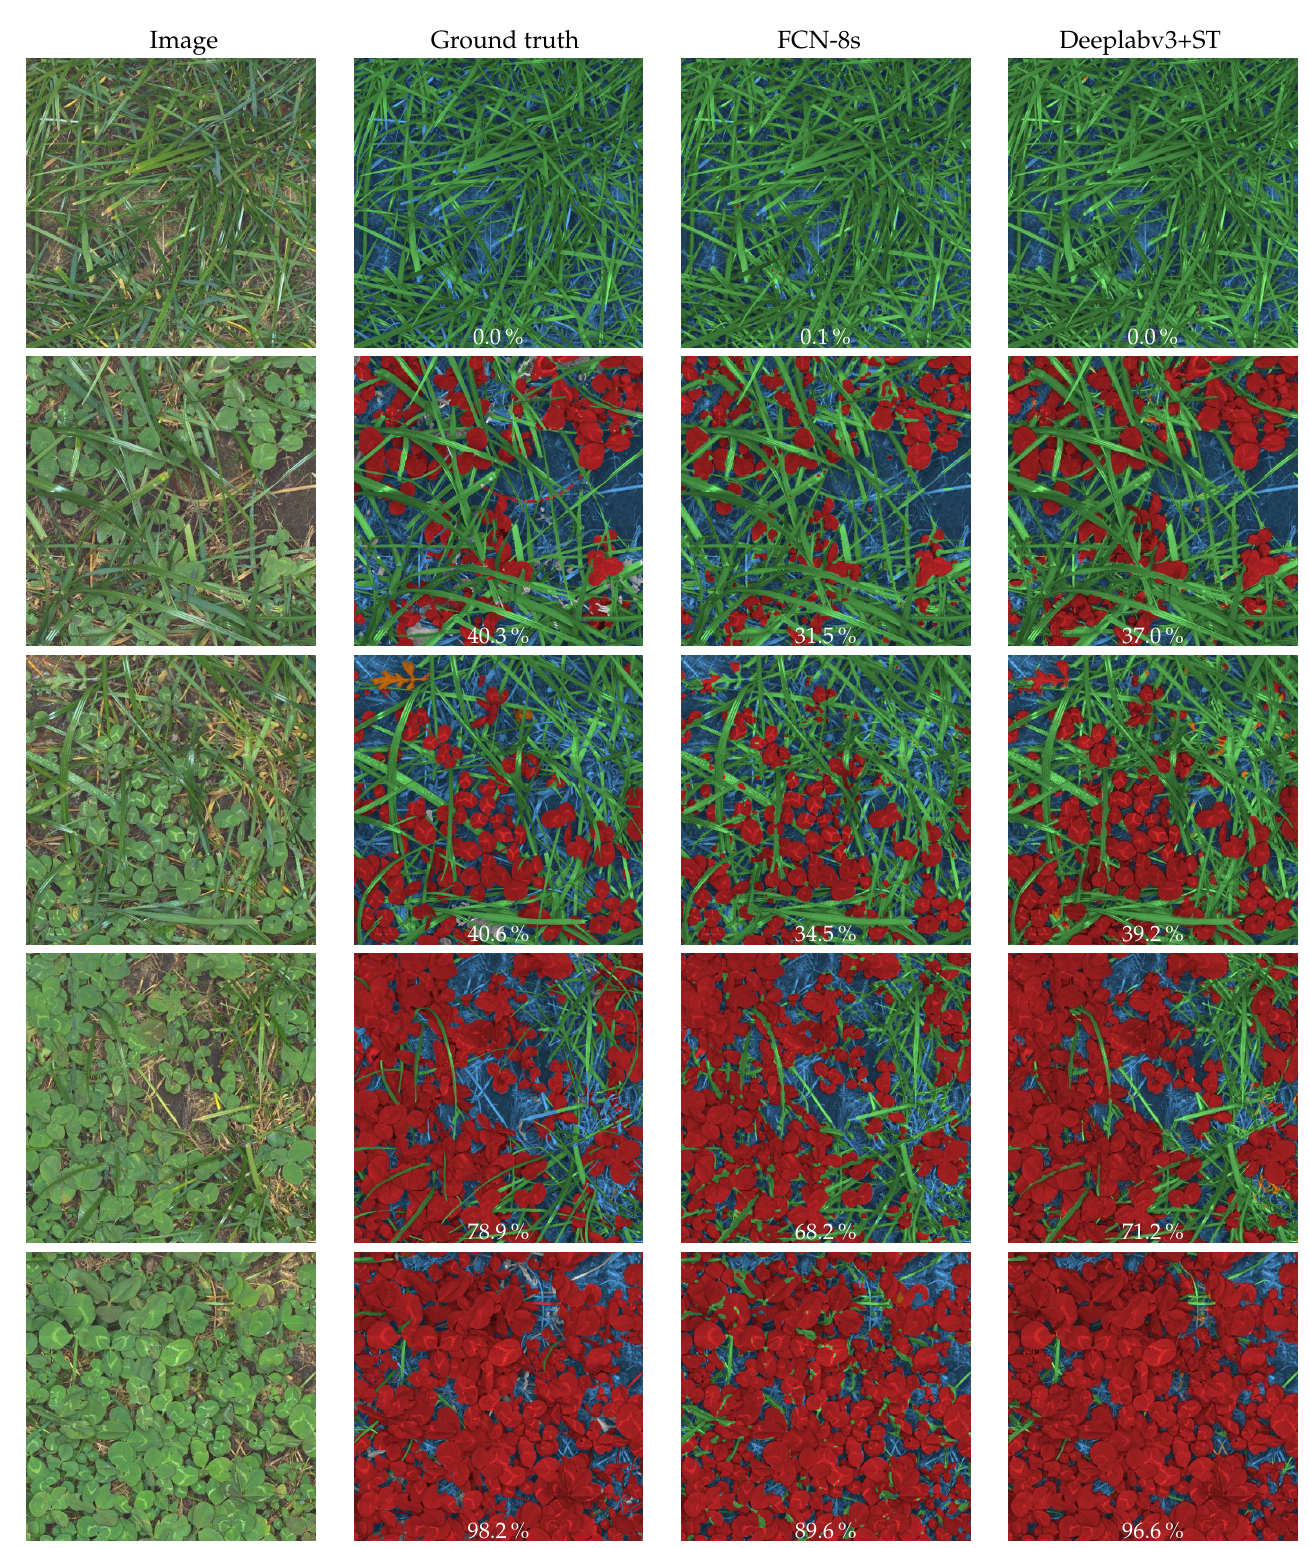
1000 pixels and corresponding semantic Figure 7. Comparison between ground truth labeled images crops of 1000 × segmentations from FCN-8s and Deeplabv3+ models. The images originate from the fall acquisition using the large scale image acquisition platform and vary in clover content. Each row represents one image. The derived clover coverage, relative to the detected canopy, is written in white text. Red is clover, green is grass, blue is soil+background, orange is weeds, and grey is unknown. The predictions from the Deeplabv3+ based model are consistently closer to the ground truth than the FCN-8s based